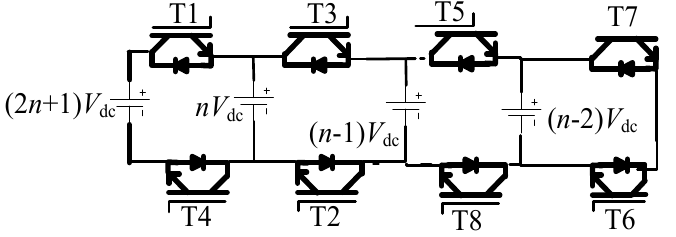
Figure 5. Extended structure of the dc-link of the proposed 4LT 2 C.